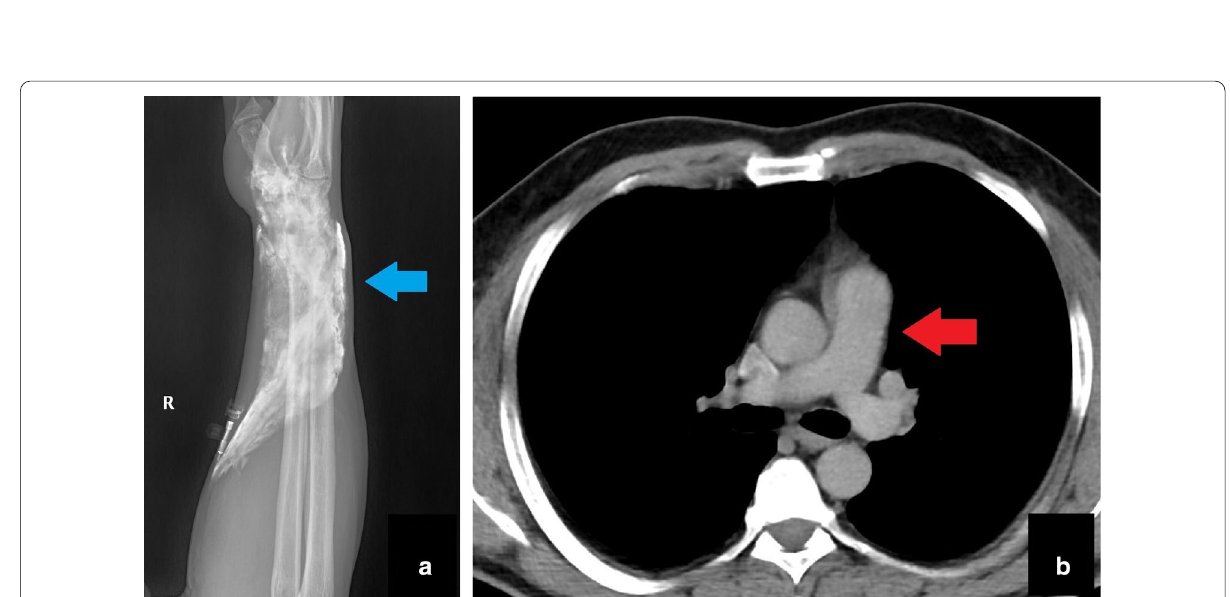
Fig. 15 A complication (Type 11 error) causing acute harm to the patient and resulting in an insufficient examination. Thorax CT with pulmonary thromboembolism (PTE) protocol was performed for a dyspneic patient with a known breast cancer history. Just after the study, the patient complained of pain and swelling in the forearm. The X-ray of the upper extremity showed extravasated contrast agent to the wrist region (blue arrow, a ). It was noted that the amount of intravascular contrast media was not sufficient for the evaluation of PTE (red arrow, b ). Medical treatment was given, and the procedure was repeated. This case is a good example of “acute and temporary harm” caused by a periprocedural